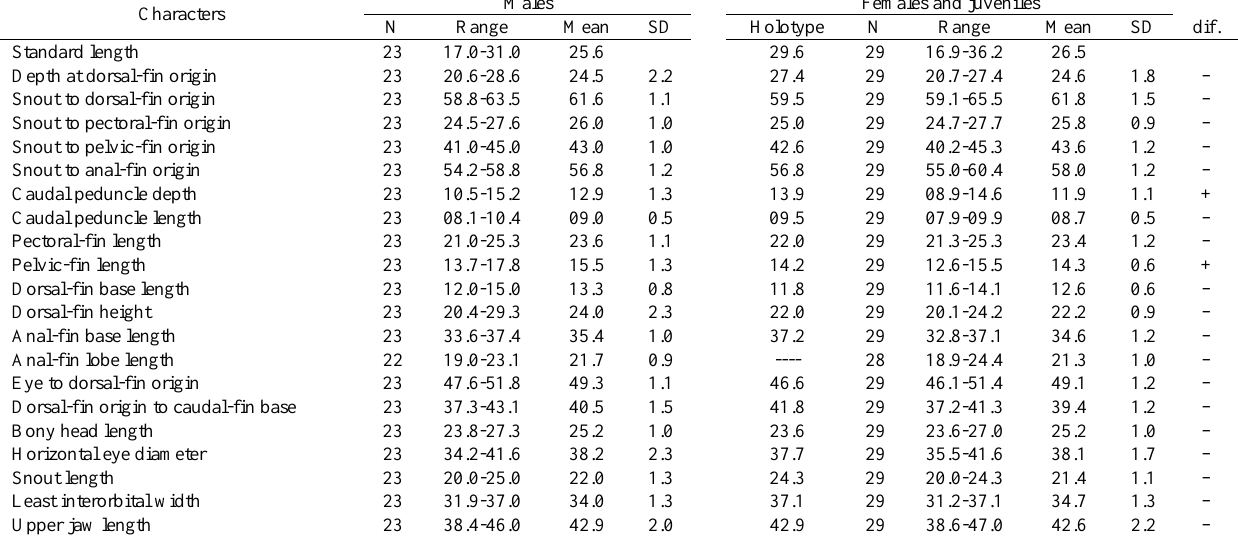
Table 9. Morphometrics of Mimagoniates lateralis . Standard length is expressed in mm; measurements through head are percentages of standard length; the last four entries are percentages head length. A plus sign under the abbreviation dif. indicates a significant difference between the males and females in the particular character indicated. Specimens are from a stream near town of Cananéia, São Paulo, USNM 326250 and an unknown locality in South America, AMNH 4072 and AMNH 4087. SD = Standard deviation.